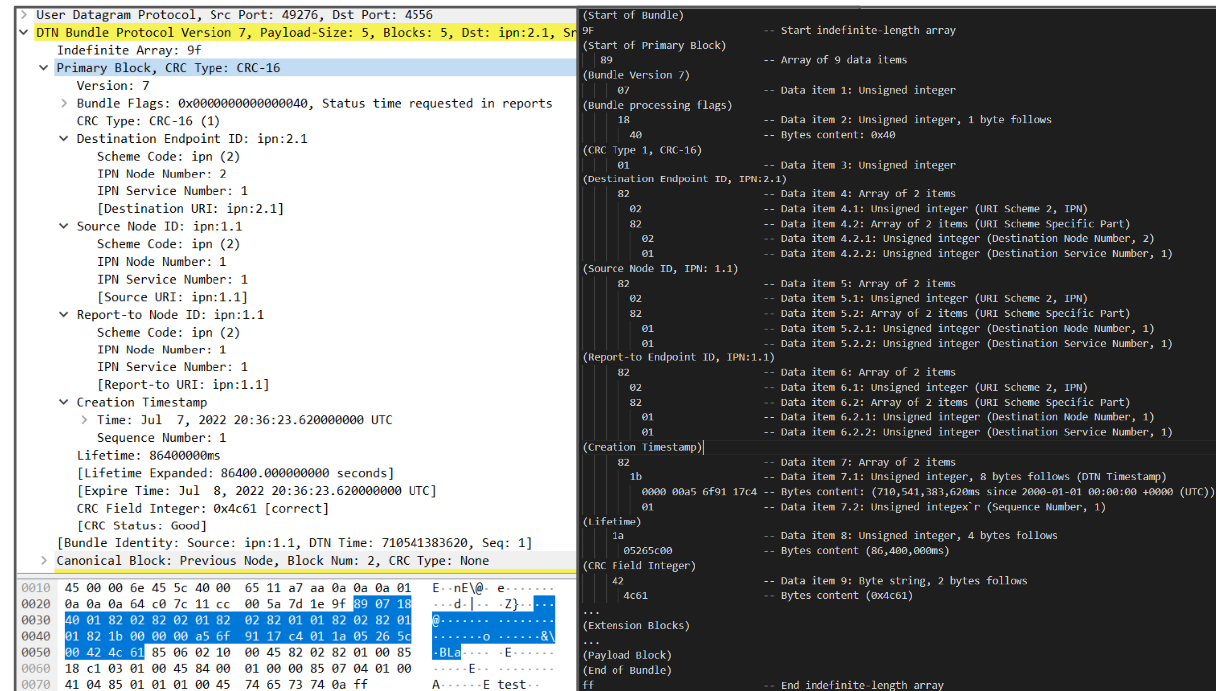
Figure 4. Decoding of BPv7 bundle ( left : Wireshark capture of BPv7 bundle with primary block bytes highlighted; right : A manual decoding of the CBOR-encoded bundle